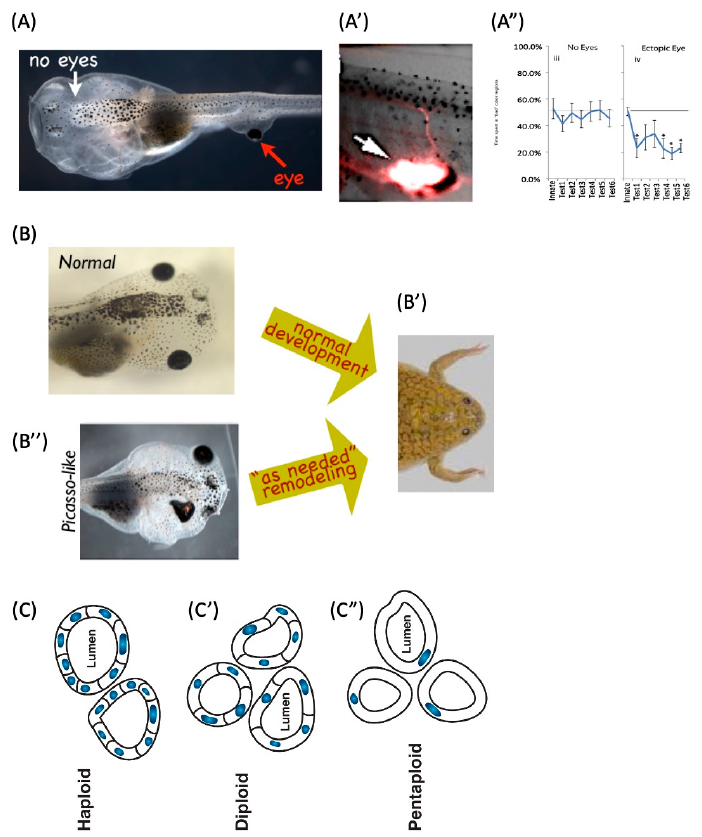
Figure 5. Morphogenesis plays the hand it is dealt. The essence of biological morphogenesis is